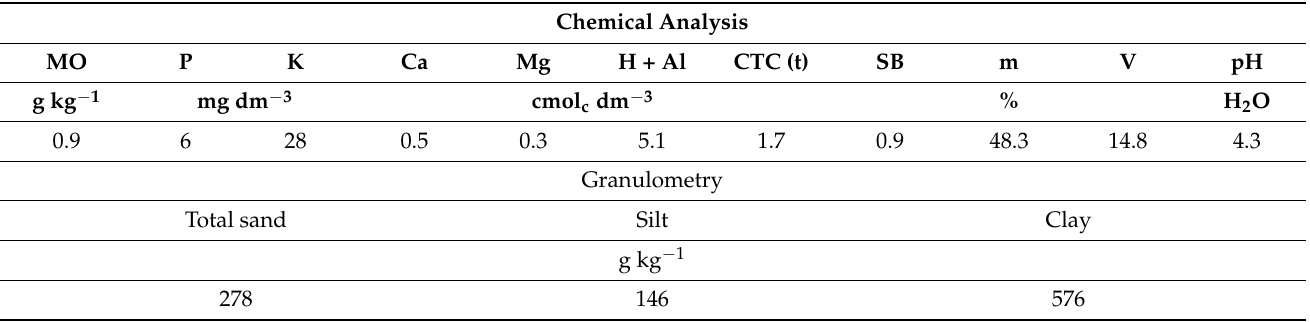
Table 1. Chemical attributes and soil granulometry in the 0–20 cm depth.